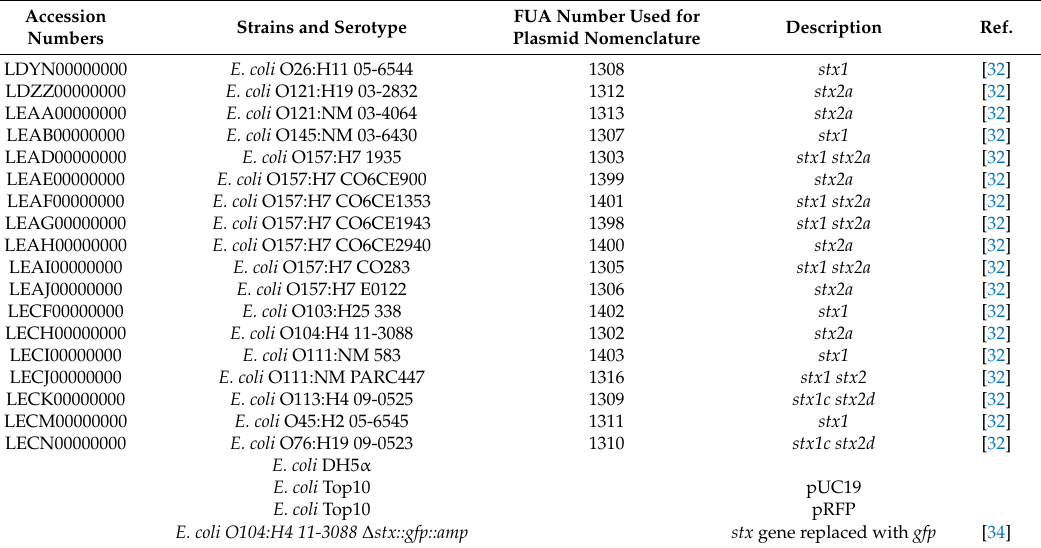
Table 1. Strains and plasmids used in this